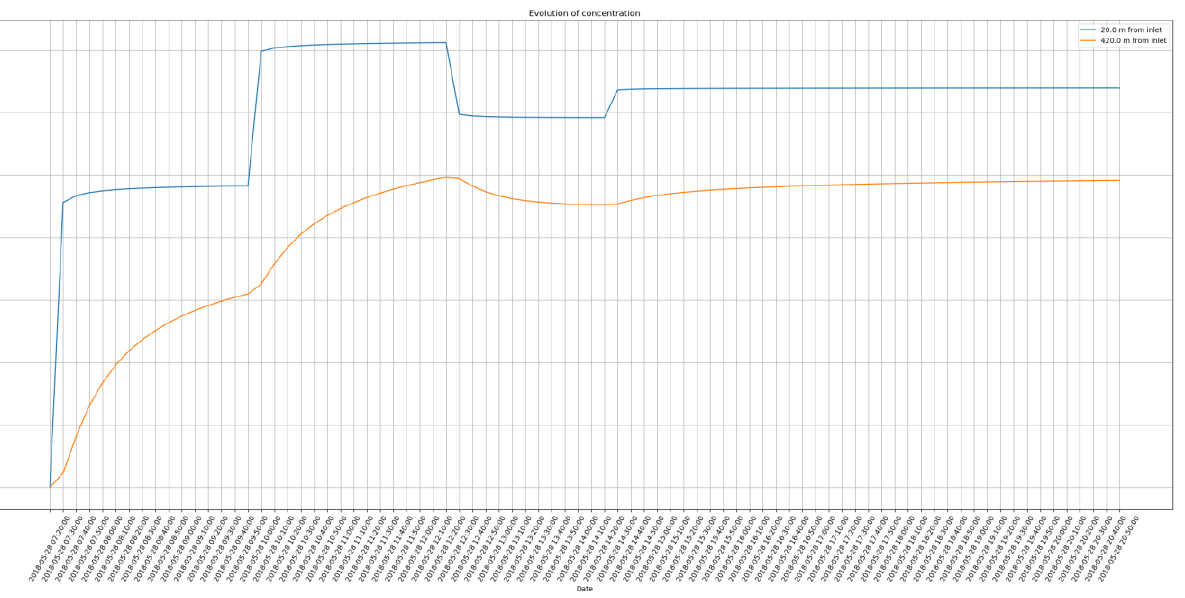
Figure 14. Simulated concentration at x = 20 m, and x = 420 m from the inlet point with 10 min time step length.